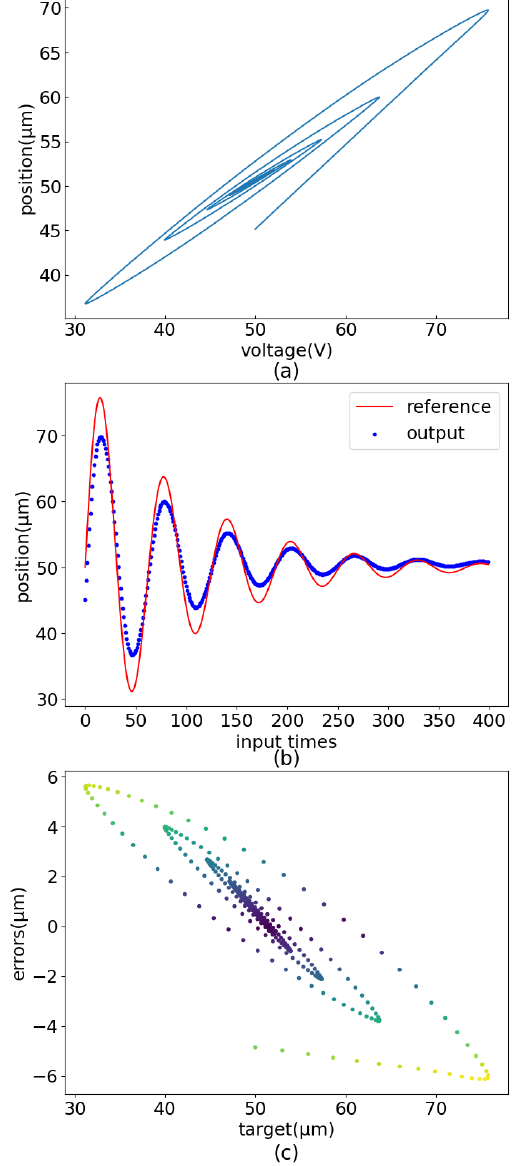
Figure 5. Secondary hysteresis loop linear analysis result graph (dampened sinusoidal input signal). ( a ) Dampened sinusoidal output. ( b ) Dampened sinusoidal curve comparision. ( c ) Dampened sinusoidal error